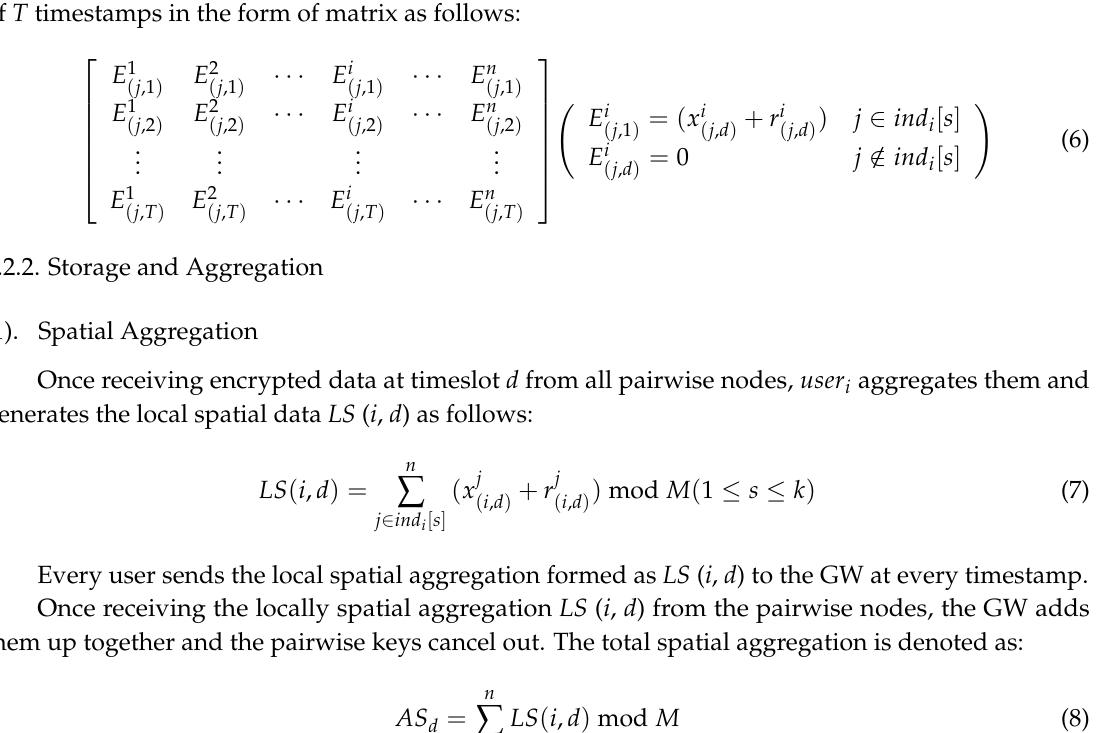
Figure 2. Example multi-region spatial and temporal aggregation.